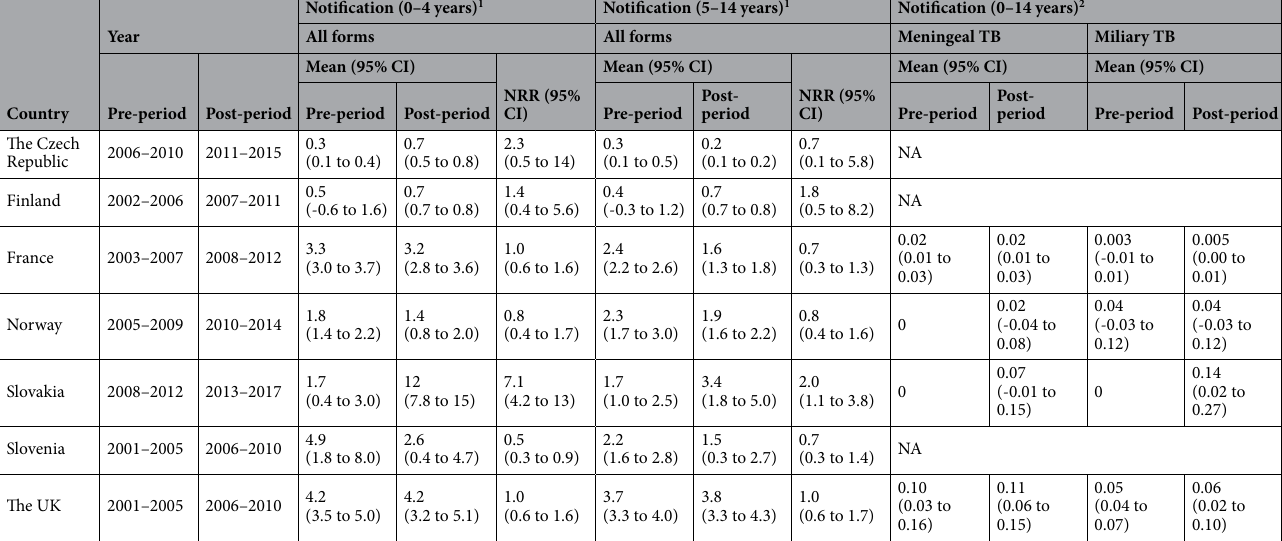
Table 3. Comparison of pre- and post-cessation period TB notification rate per 100,000 population. 1 Data source: ECDC (https:// www. ecdc. europa. eu/ en/ surve illan ce- and- disea se- data). 2 Data sources: The World Bank for population data; Sante Publique France; The Norwegian Institute of Public Health; National Institute for TB, Lung Diseases and Thoracic Surgery in Slovakia, and Public Health England for the number of TB notifications. CI confidence interval, NRR notification rate ratio, TB tuberculosis, UK United